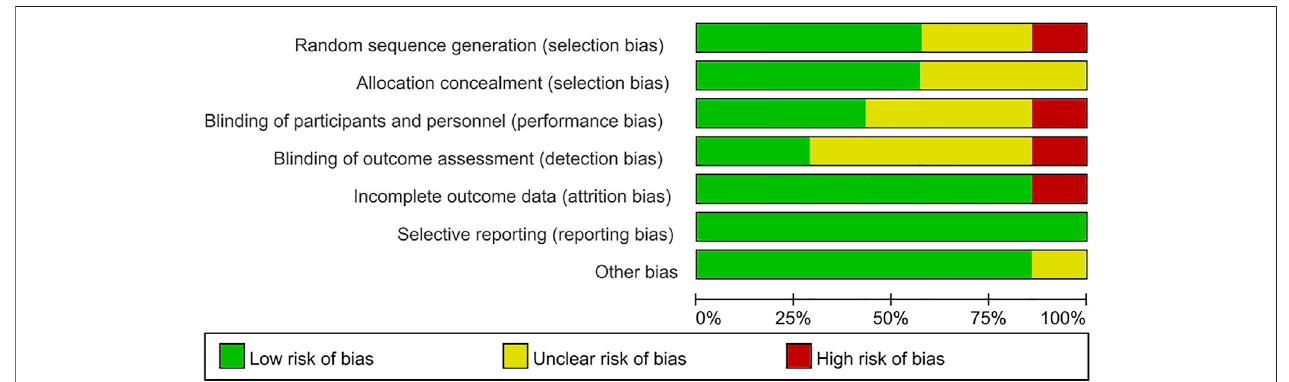
FIGURE 3 | Risk of bias graph.